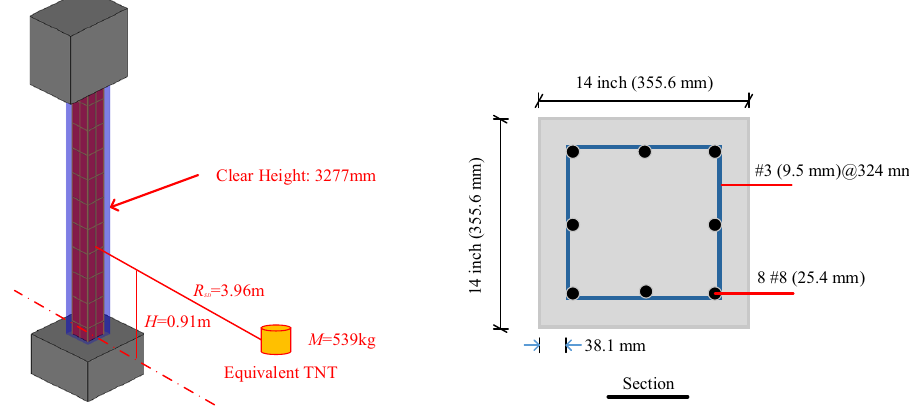
Fig. 1 CTEST20 column configuration and reinforcement